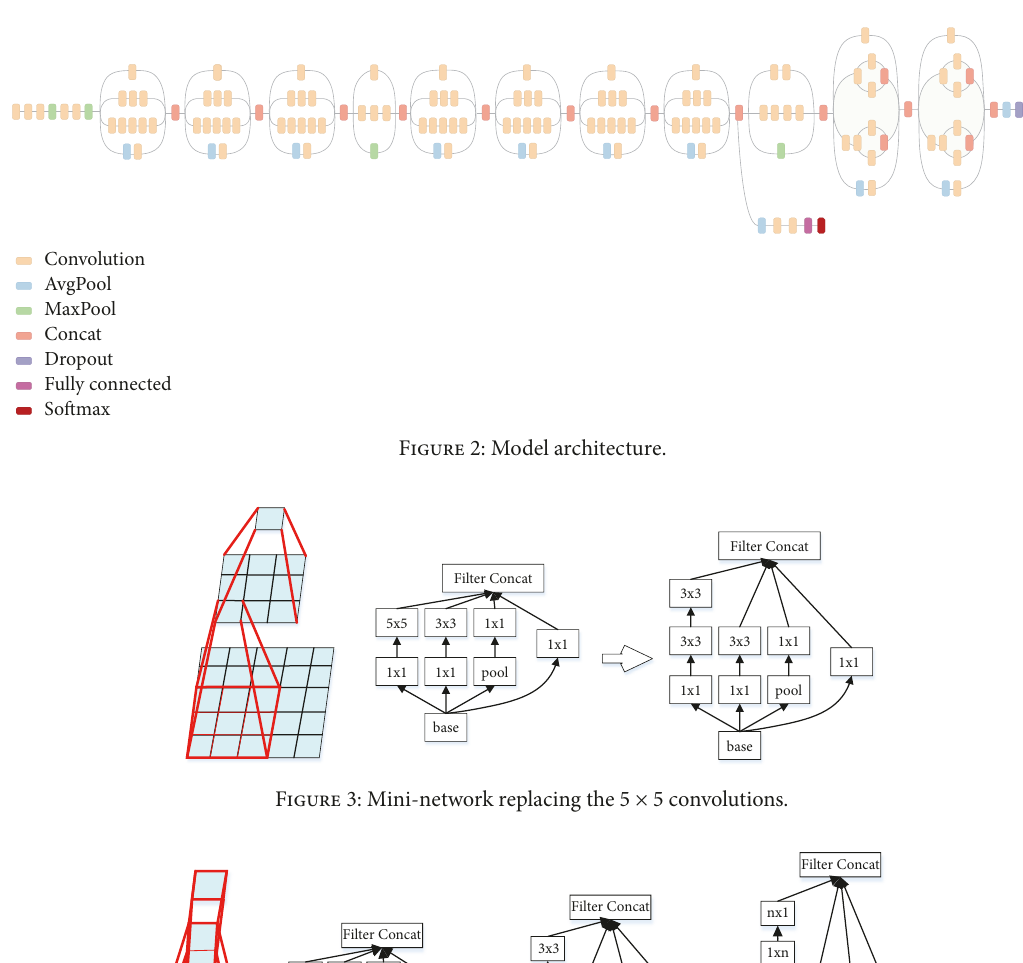
Inception module was optimized. The visualization of the model architecture is given in Figure